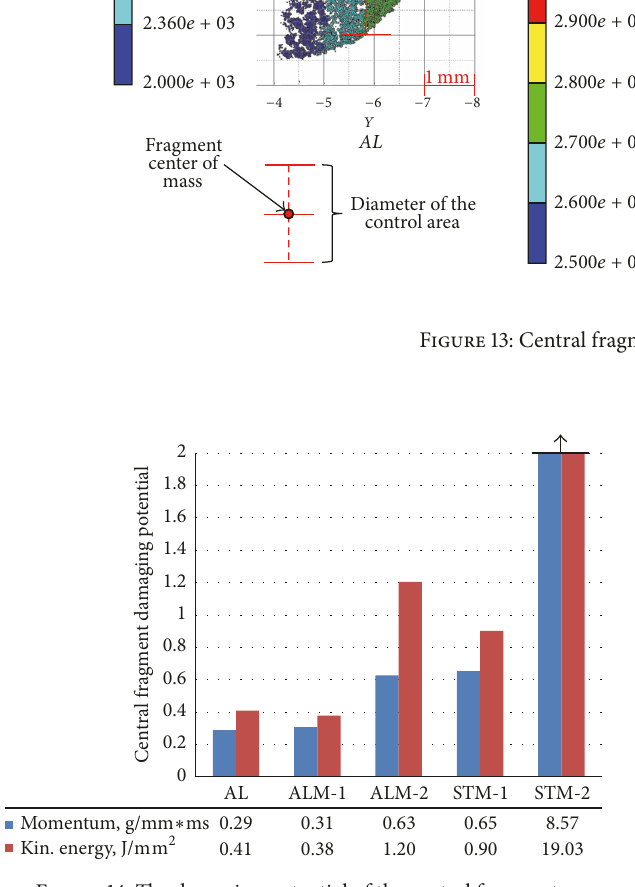
much larger control areas associated with them. Although crossover-centered impact on a bumper with steel mesh results in lower damaging potential of the central fragment as compared to aperture-centered impact, the fragment’s residual momentum and energy are still significantly higher than those that form in case of all-aluminum